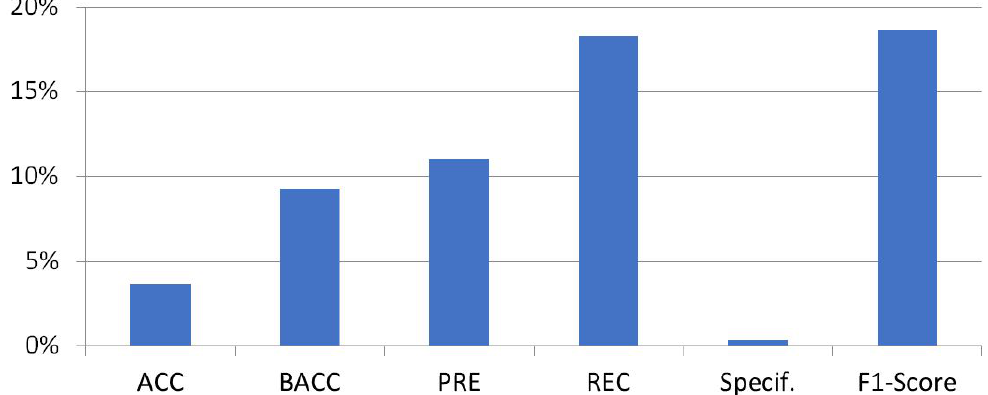
Figure 9. Mean improvement for 2020 and 2021 in the classification performance of foreground sounds compared to background